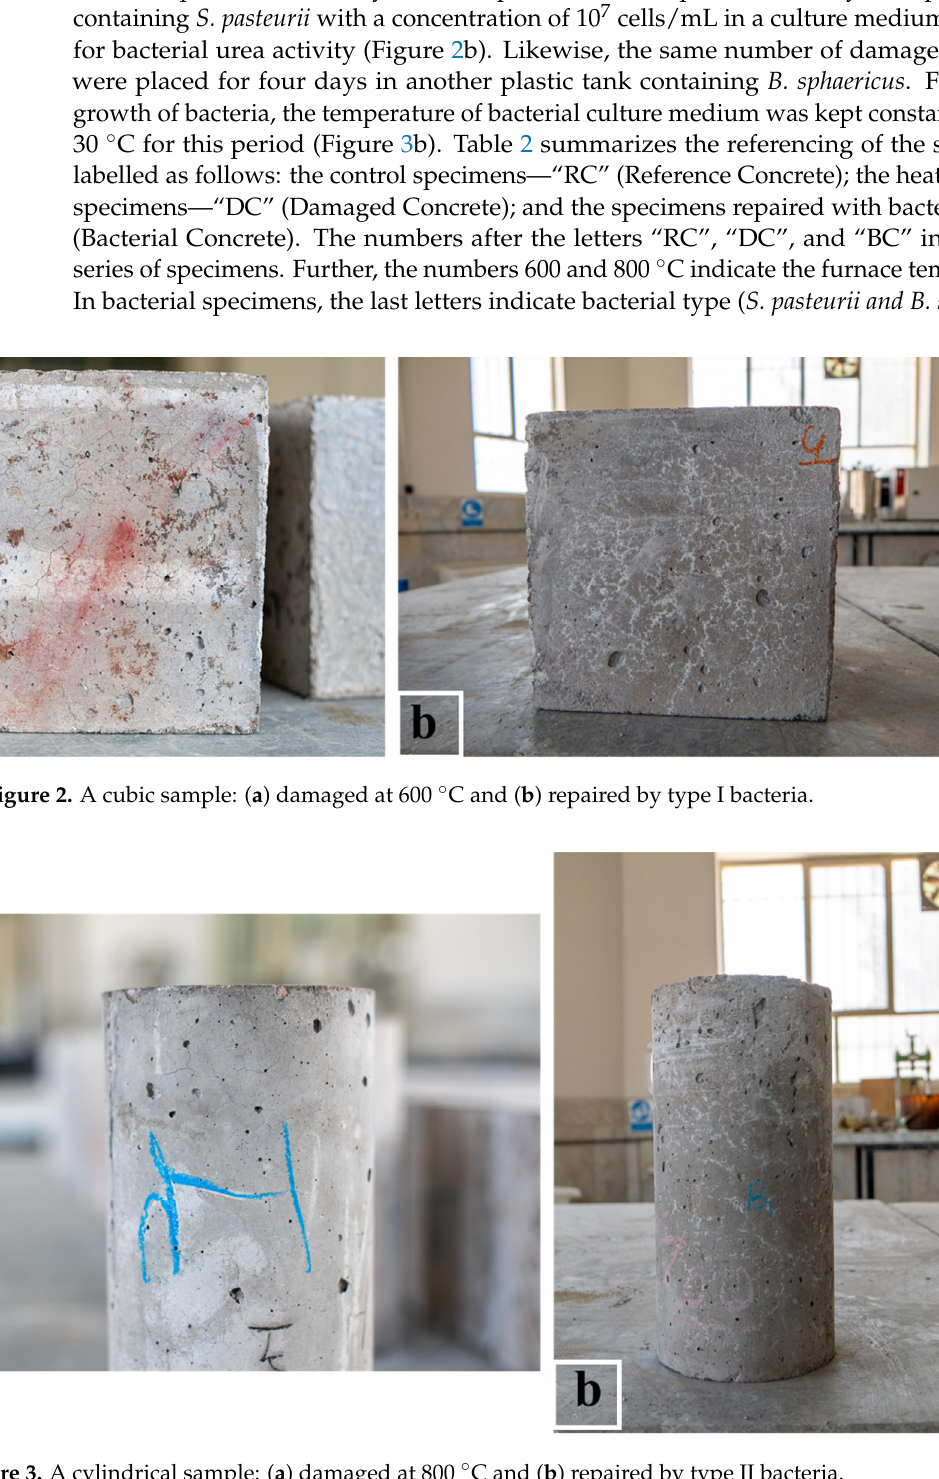
Figure 3. A cylindrical sample: ( a ) damaged at 800 °C and ( b ) repaired by type II bacteria.